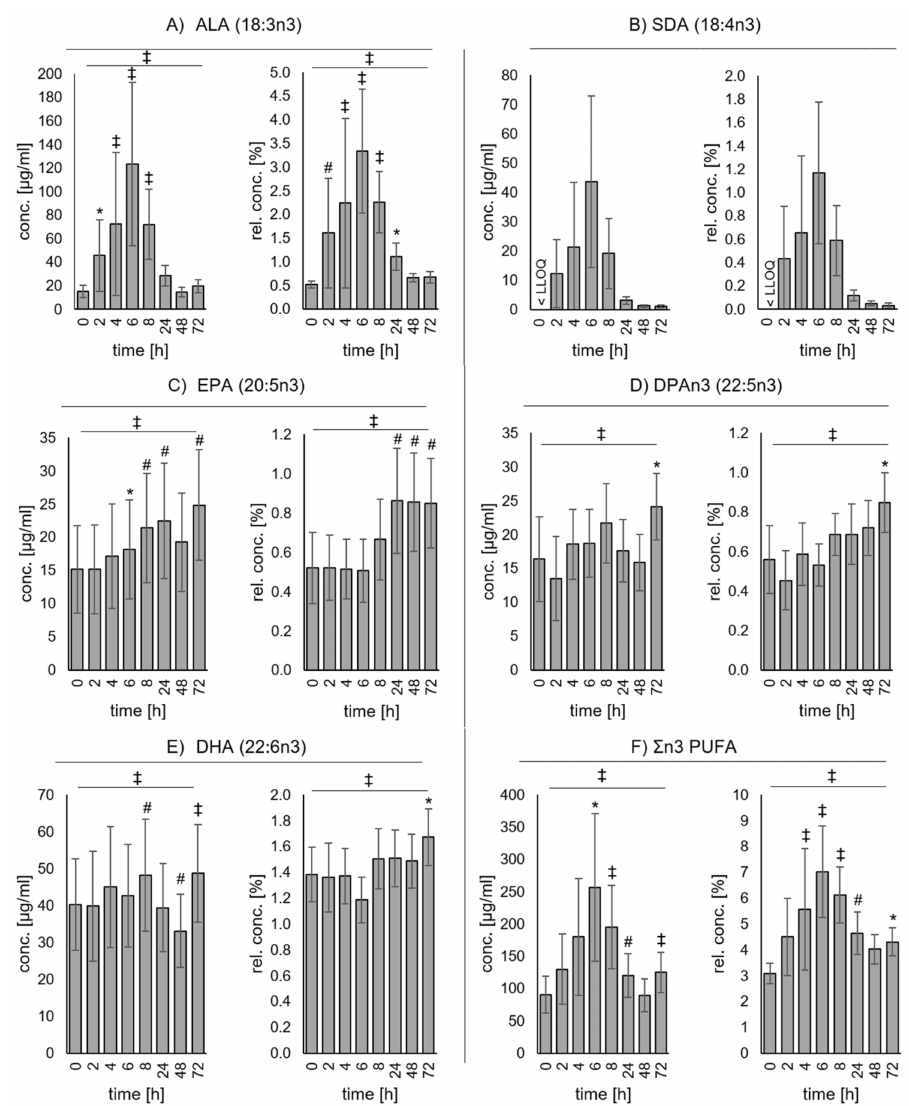
Figure 1. Concentration of selected omega-3 polyunsaturated fatty acids in plasma after single-dose ingestion of echium oil. Concentration of ( A ) α -linolenic acid (ALA, 18:3 n 3), ( B ) stearidonic acid (SDA, 18:4 n 3), ( C ) eicosapentaenoic acid (EPA, 20:5 n 3), ( D ) docosapentaenoic acid (DPA n 3, 22:5 n 3), ( E ) docosahexaenoic acid (DHA, 22:6 n 3), and ( F ) sum of omega-3 polyunsaturated fatty acids ( Σ n 3 PUFA) in plasma at baseline 0, and 2, 4, 6, 8, 24, 48, 72 h after single-dose ingestion of echium oil. Levels are shown as concentrations [ µ g / mL] and as relative concentrations (%) of total fatty acids. All data are shown as mean ± standard deviation. Levels of significance (for normally distributed variables: one-factorial ANOVAs with repeated measurements and t-tests for paired samples with Holm–Bonferroni correction; for not normally distributed variables: Friedman test followed by Dunn–Bonferroni post-hoc test) are indicated as follows: * p ≤ 0.05, # p ≤ 0.005, ‡ p ≤ 0.001. < LLOQ, below lower level of